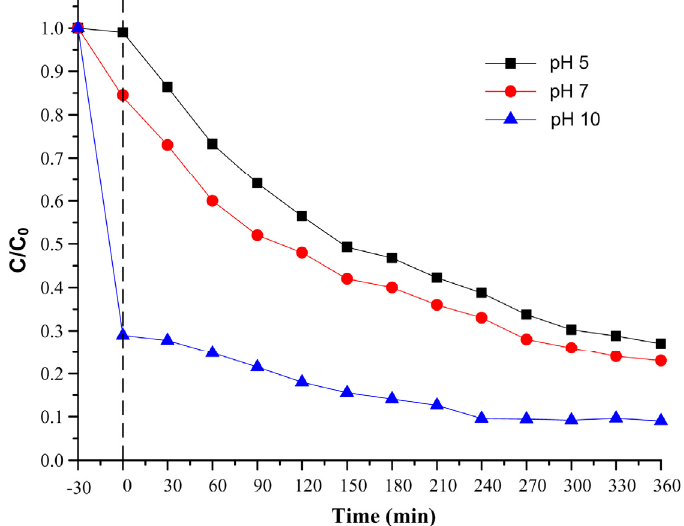
Figure 14. Photocatalytic decolorization of MB solution using different initial pH values (100 mg ZnS:CdS